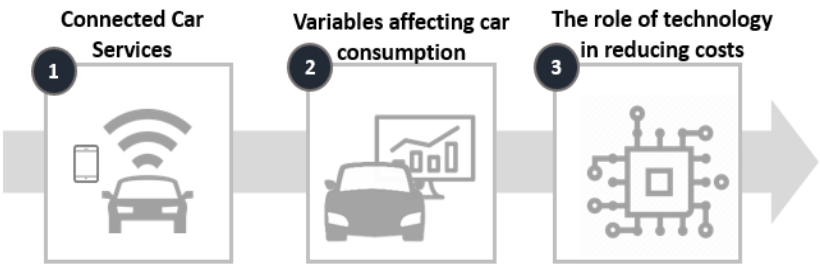
Figure 1. Literature review framework.